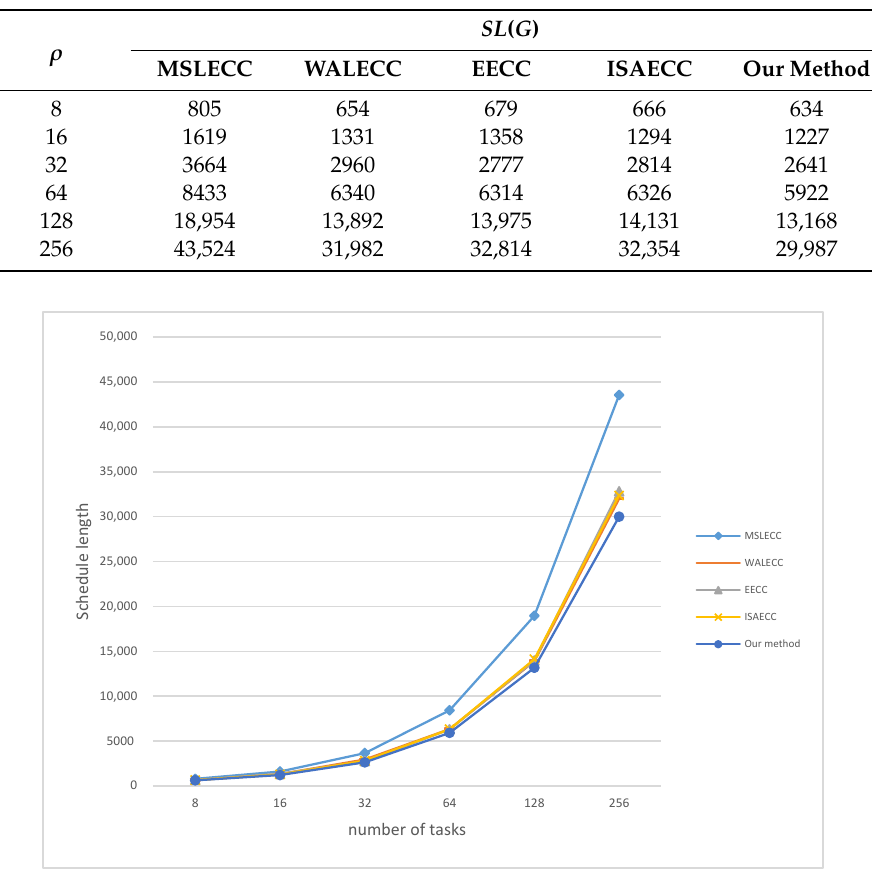
Figure 4. Final schedule length of FFT application varying number of tasks.